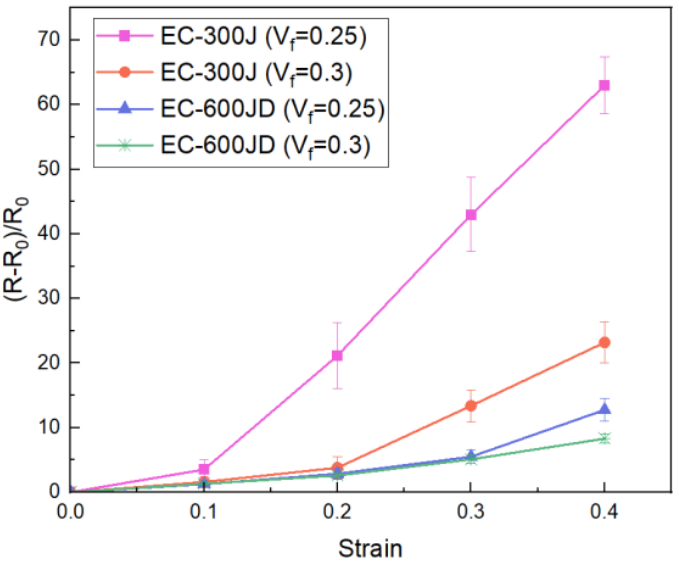
Figure 9. Predicted electromechanical responses of CNPs − filled silicone composite with EC − 600JD and EC − 300J fillers under uniaxial tensile loading ( V f is the volume fraction).